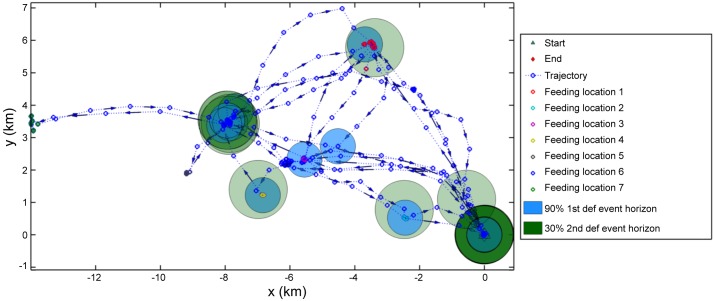
Seed shadow plot with multiple feeding events.Sample trajectory with several different feeding events and locations from one bat covering nearly a week of feeding. The start and end of the trajectory are at the roost (0,0) with two defecation event horizons shown for each feeding event. The light green and blue colour indicates a single defecation event while the darker colours indicate more than one overlapping circle due to several defecation events. The small blue dots are GPS fixes.